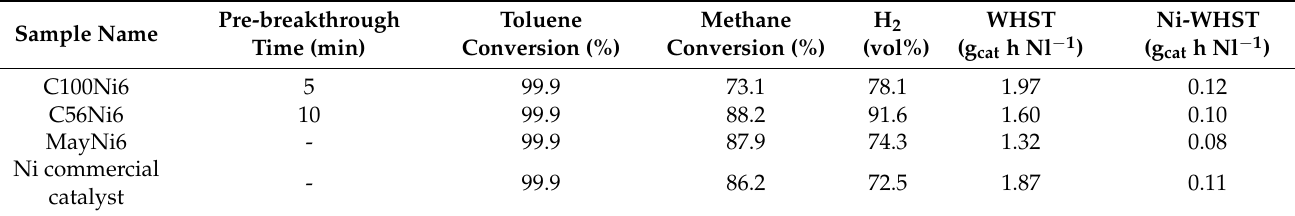
Table 9. Impregnated samples summary results.